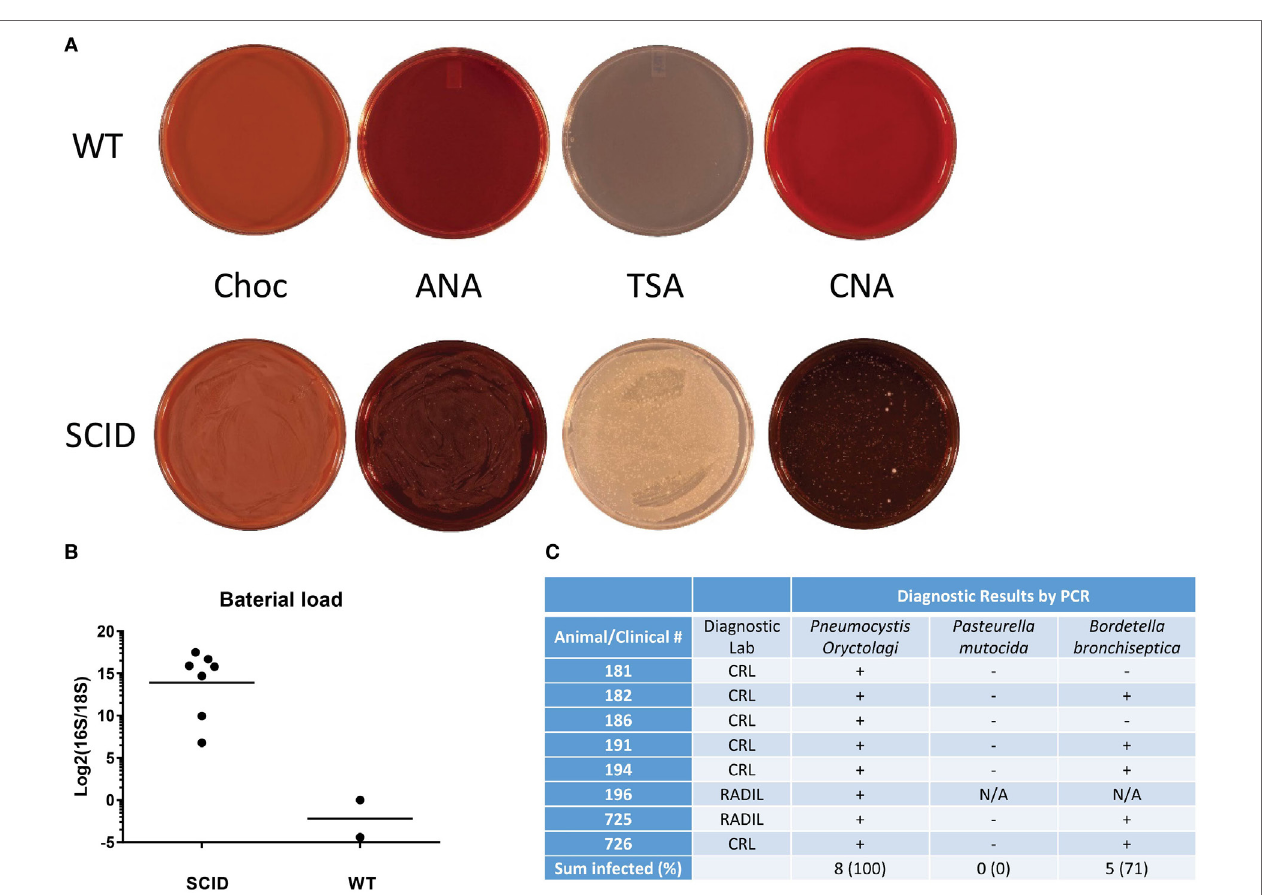
FigUre 4 | Bacterial and P. oryctolagi identification in severe combined immunodeficiency (SCID) rabbits. (a) Bronchoalveolar lavage culture of SCID and wild-type (WT) rabbits on chocolate (Choc), anaerobic (ANA), tryptic soy agar (TSA) and Columbia colistin-nalidixic acid (CNA) plates. (B) Bacterial load, indicated by 16S/18S rRNA gene ratio, in the lungs of SCID and WT rabbits. (c) Diagnostic PCR results for P. oryctolagi, P. mutocida , and B. bronchiseptica in the lungs of SCID